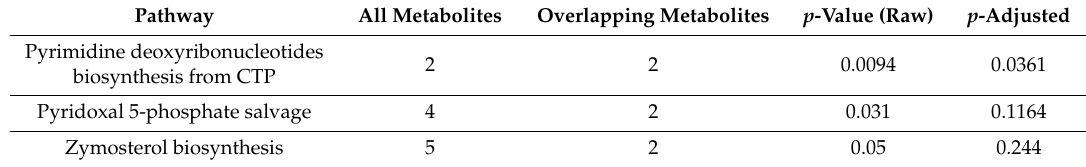
Table 3. Pathways identified by highly modulated metabolites between PRE run and POST run